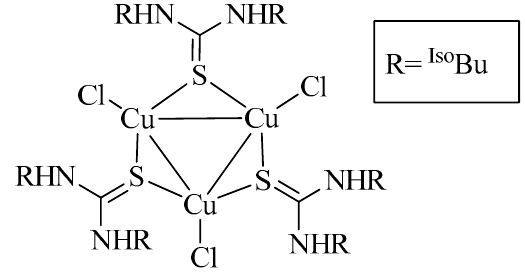
Figure 1. Trimeric copper complex, 1 .